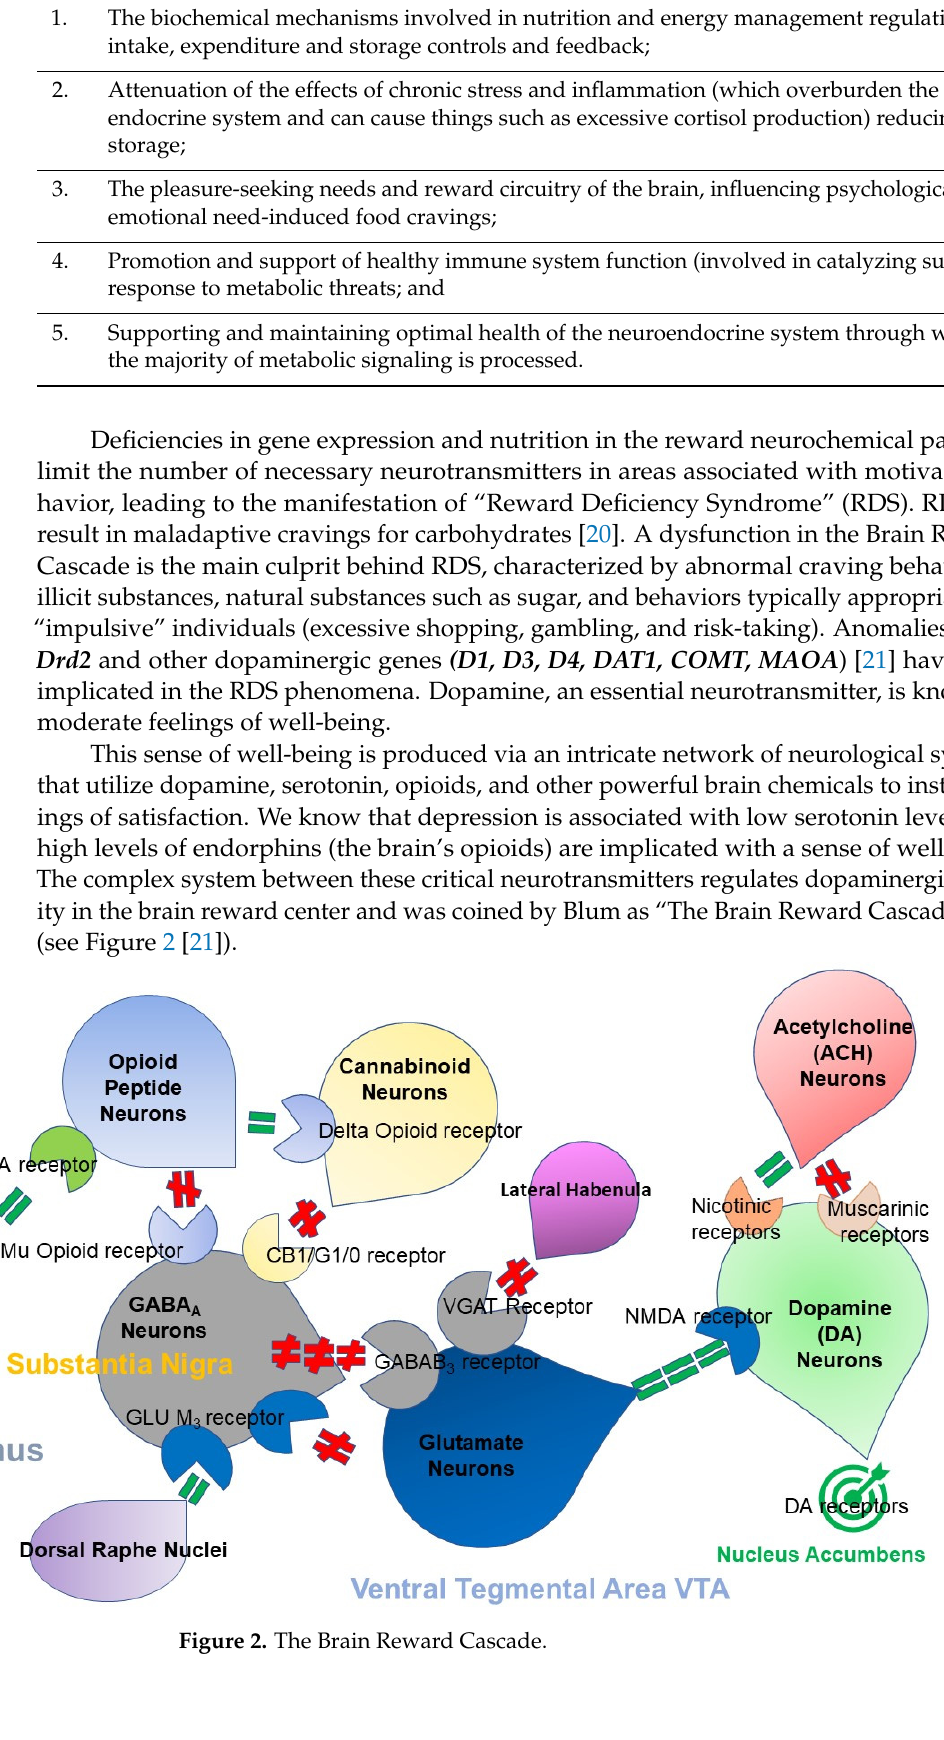
Table 1. Systems to improve weight management.